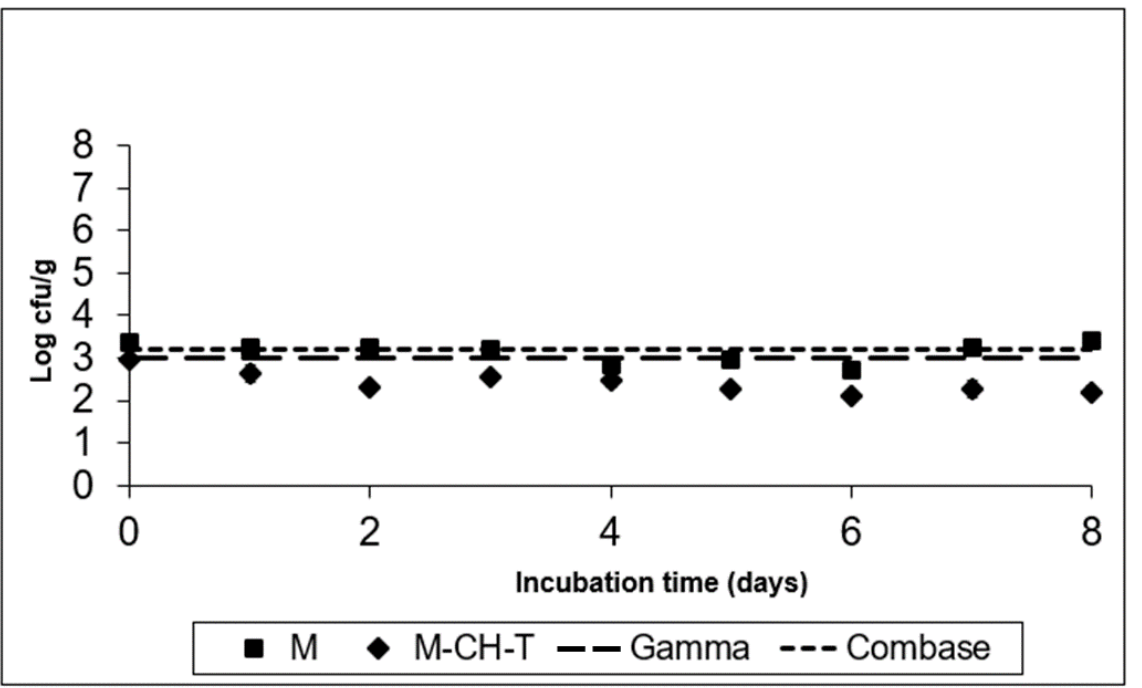
Figure 3. Growth of S. Montevideo on the RTC product stored at 4 °C, under MAP (M; ■ ), under MAP with Chitosan/Thyme oil (M-CH-T; ♦ ) using the Gamma prediction model ( —— ) and the Com-base ® model (- - - ). M denotes RTC product, stored under MAP and M-CH-T a product stored under MAP, treated with Chitosan and Thyme.